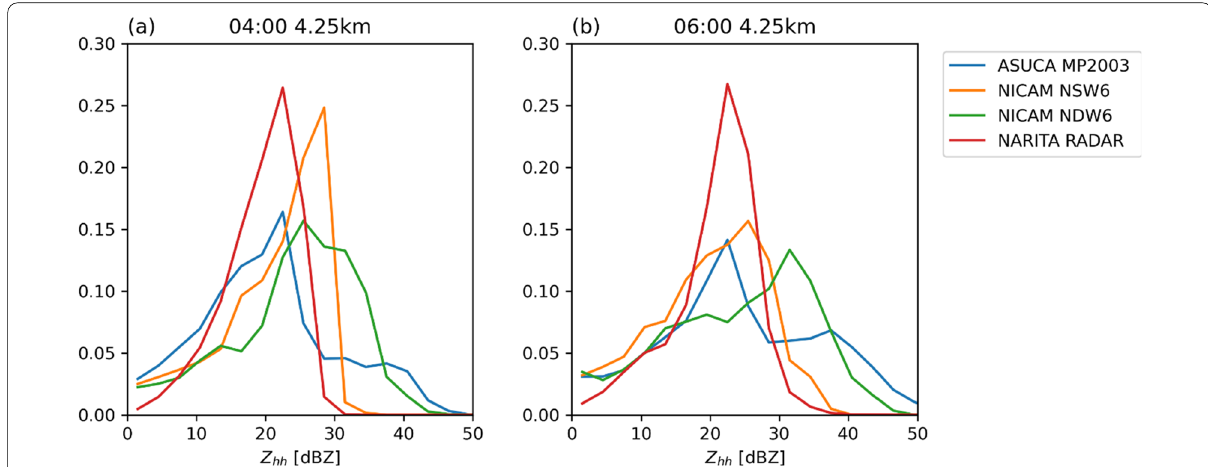
Fig. 19 Comparison of the probability distributions of Z hh at an altitude of 4.25 km. a at 04:00 UTC, b at 06:00 UTC, April 18, 2020. The observation of the Narita radar (red), ASUCA (blue), NICAM-NSW6 (orange), and NICAM-NDW6